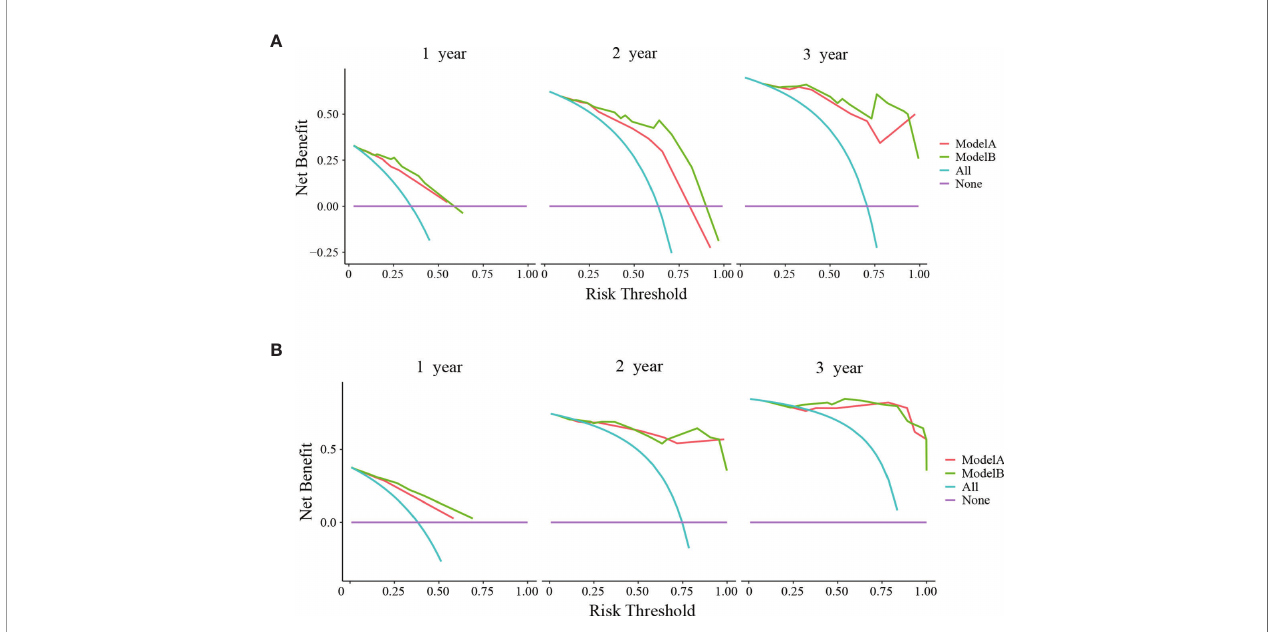
FIGURE 2 | Decision curve analyses (DCA) of ModelA and ModelB at 1, 2, and 3 years after surgery in the training cohort (A) and 1, 2, and 3 years after surgery in the validation cohort (B) . The y-axis represents the net bene fi t and the x-axis represents the corresponding risk threshold. The blue line represents that all patients die during the follow-up. The purple line represents that no patients die during the follow-up. In the most points of risk threshold, ModelB (green line) showed more bene fi ts in predicting survival status than ModelA (red